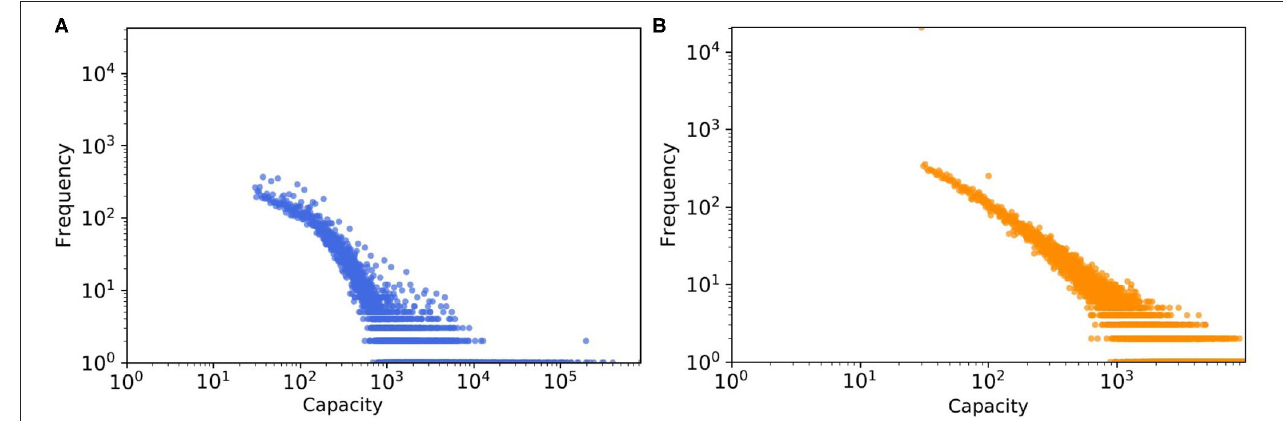
FIGURE 10 | The tail of capacity distribution of (A) real pig trade network which estimated from batch size and (B) one realization of a synthetic data, here capacity values generated from the fitted probability distribution.